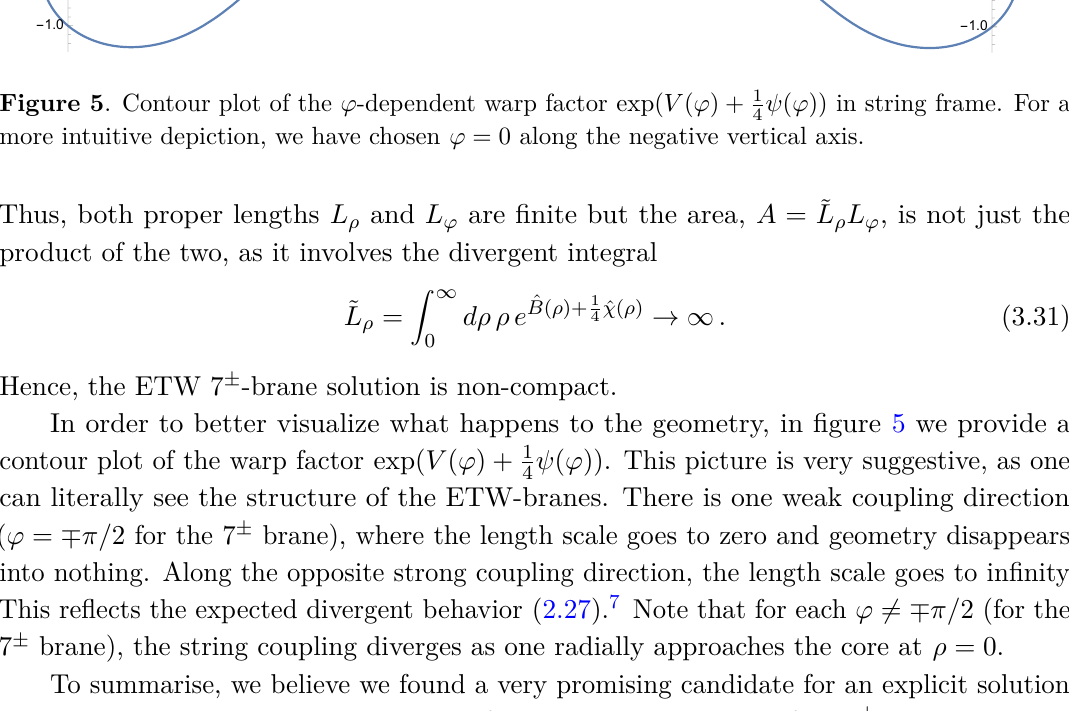
ψ ( ϕ )) in string frame. For a 4